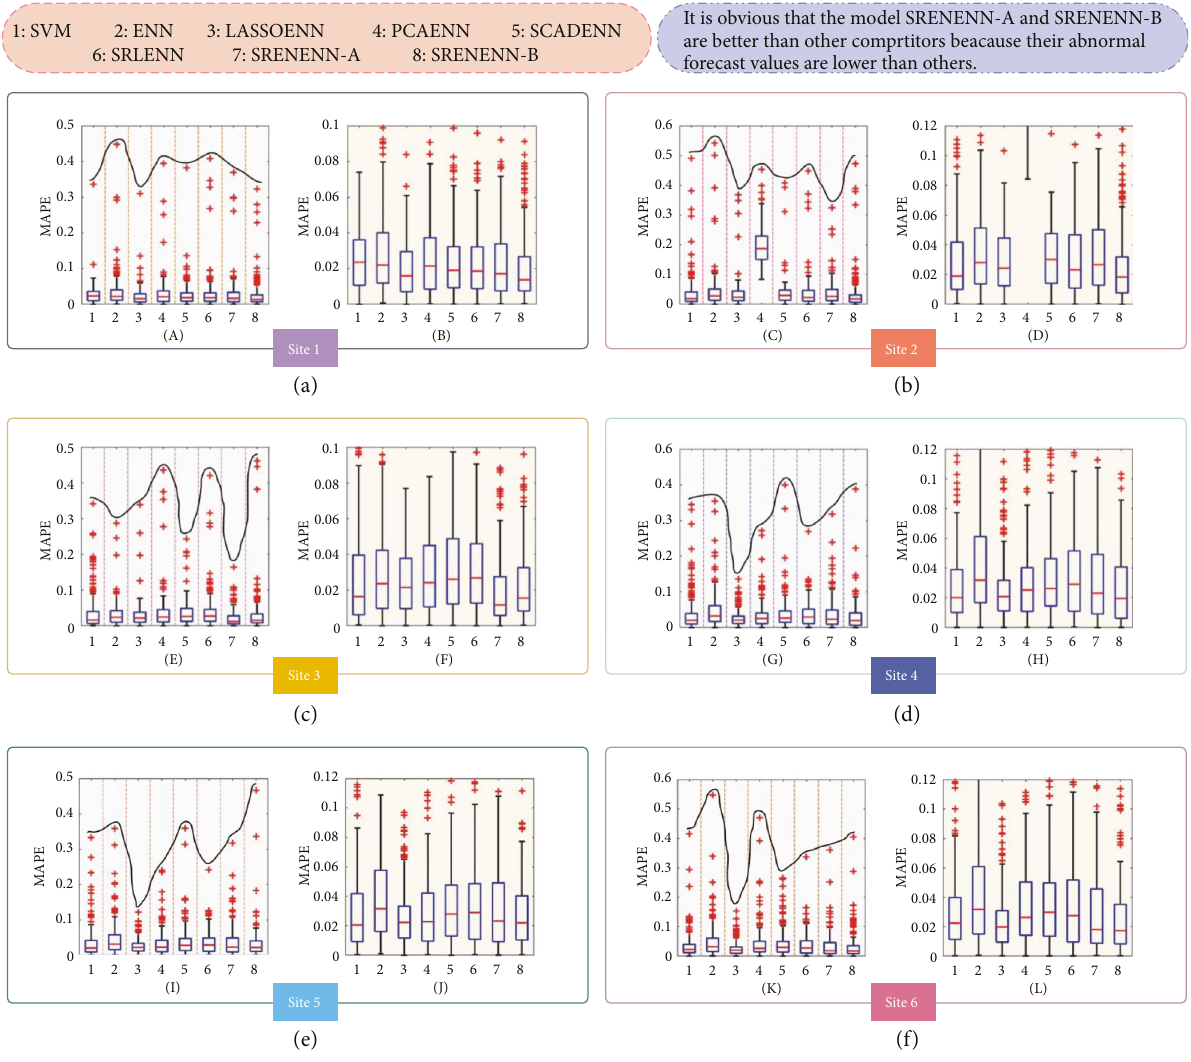
Figure 6: Boxplot of RMSEs of ENN, (a) LASSOENN, (b) PCAENN, (c) SCADENN, (d) SRLENN, (e) SRENENN-A, and (f) SRENENN-B for six sites in one year. (A, C, E, G, I, K) presents the RMSEs of each model without any limitation, and (B, D, F, H, J, L) presents the RMSEs of each model with the